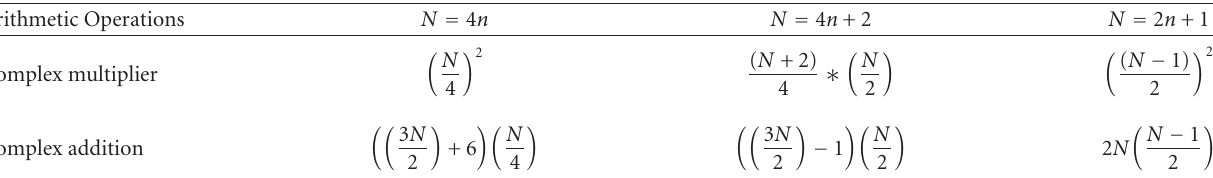
Table 1: Number of complex operations for DFT/IDFT based on proposed factorization technique.